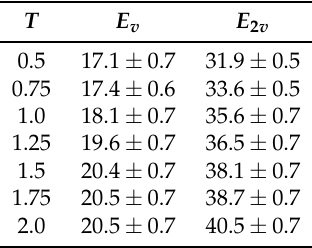
Table 1. Vacancy formation energy for a single vacancy E v , and for two vacancies E 2 v in a fcc 4 He crystal with N = 108 sites, at density ρ = 0.0294 Å − 3